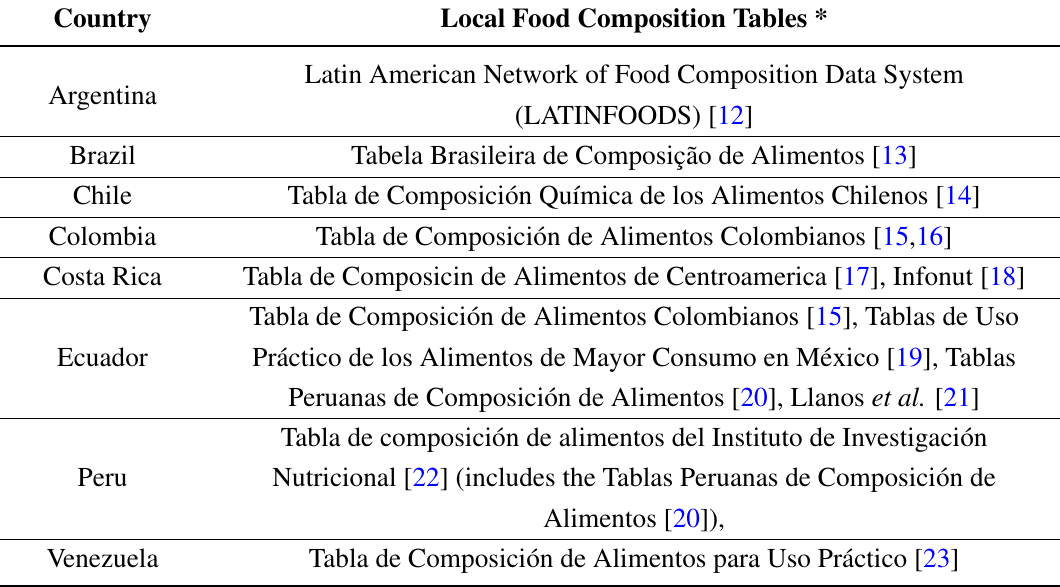
Table 2. Local food composition tables used in the food matching process. Country